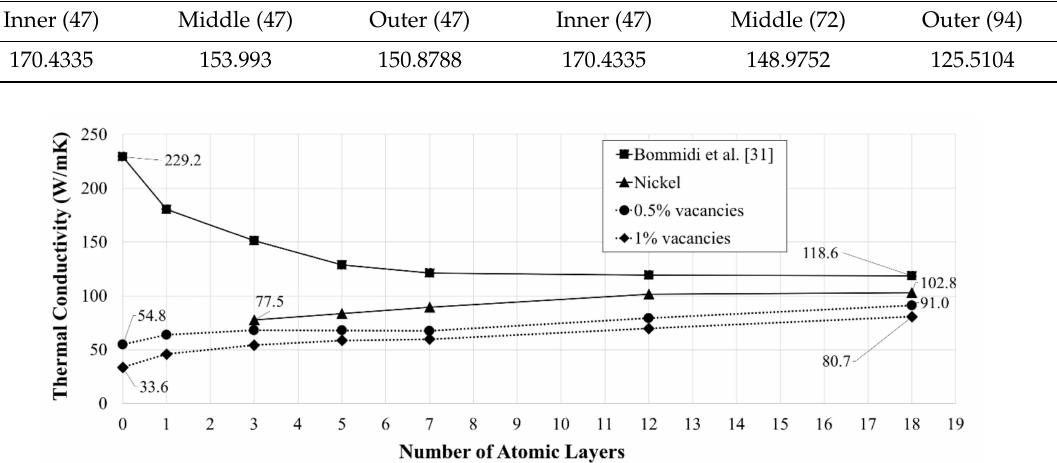
Figure 6. Variation in thermal conductivity of a Ni-coated 3WCNT with varying Ni thickness. Each data point shows the average of a set of three simulations implying three di ff erent patterns of (same) vacancy